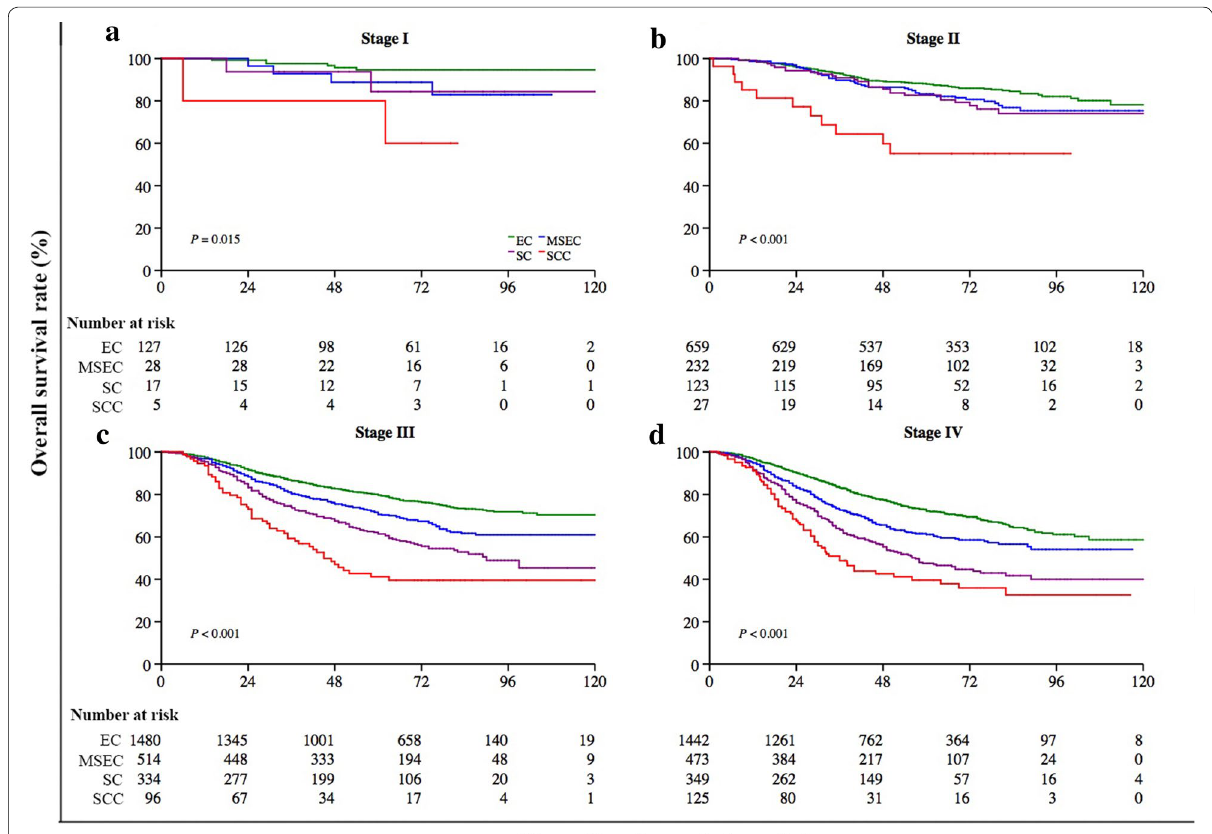
Fig. 6 Kaplan‑Meier survival estimates for NPC patients at different clinical stages (the 1992 China and 1997 AJCC staging systems combined) strati‑ fied by subtypes according to the proposed histopathologic classification. The OS differed significantly by the proposed classification for patients with stage I ( P 0.015, a ), II ( P < 0.001, b ), III ( P < 0.001, c ), or IV disease ( P < 0.001, d ). The log‑rank test was used to calculate P =